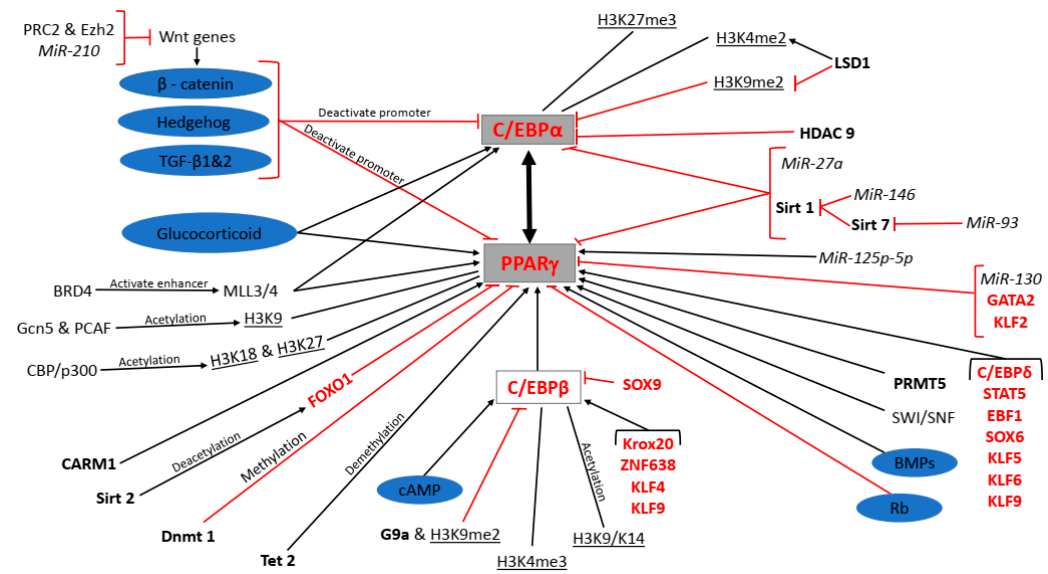
Figure 1. Molecular regulation of peroxisome proliferator-activated receptor gamma (PPAR γ ) and CCAAT-enhancer-binding protein alpha (C/EBP α ) expression during adipogenesis. Signalling pathways are shaded purple, miRNAs in italics, enzymes in bold, transcription factors in red, epigenetic modifications underlined, protein complexes and genes in standard font and the master regulators of terminal differentiation shaded grey.